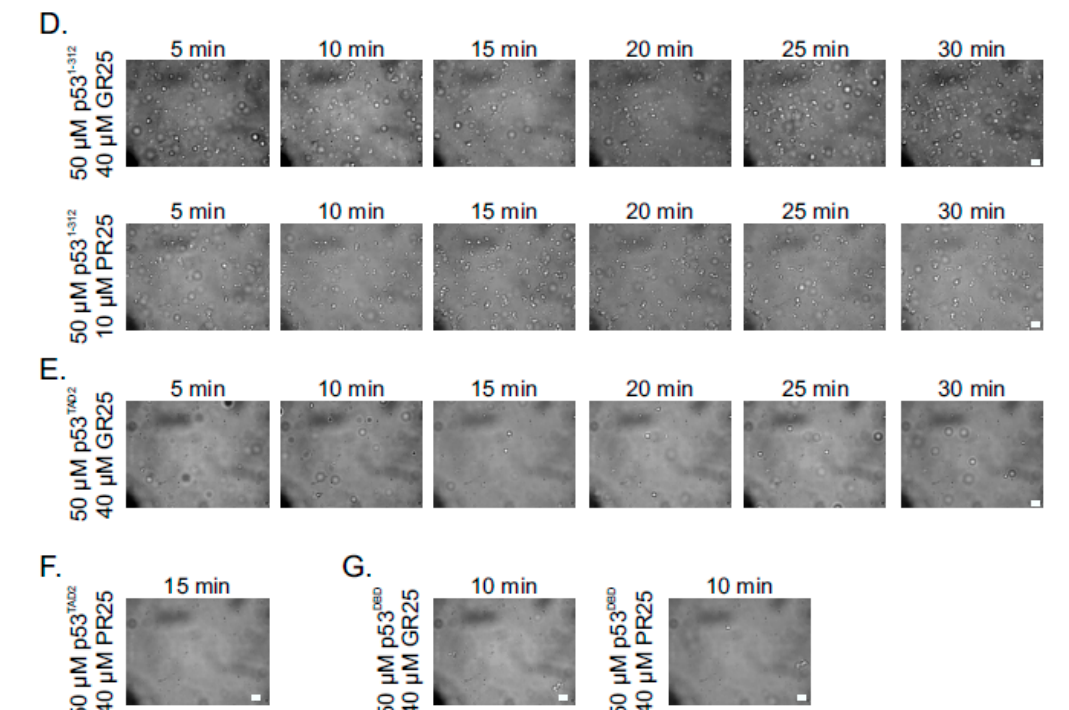
Figure 4. PR25/GR25 modulate LLPS of p53. ( A , B ) Turbidity assays to quantify phase separation of p53 domains with fixed p53 concentrations (50 µ M) and increasing either GR25 concentration in ( A ) or PR25 concentration in ( B ). Values represented mean ± SD (n = 3); ( C ) DIC microscopy images of p53 1 − 94 at 50 µ M in the presence of either 100 µ M GR25 (upper panel) or 100 µ M PR25 (bottom panel); ( D ) DIC microscopy images of p53 1 − 312 at 50 µ M in the presence of either 40 µ M GR25 (upper panel) or 10 µ M PR25 (bottom panel); ( E , F ) DIC microscopy images of p53 TAD2 at 50 µ M in the presence of either 40 µ M GR25 in ( E ) or 40 µ M PR25 in ( F ); ( G ) DIC microscopy images of p53 DBD at 50 µ M in the presence of either 40 µ M GR25 ( left ) or 40 µ M PR25 ( right ). Scale bar, 10 µ